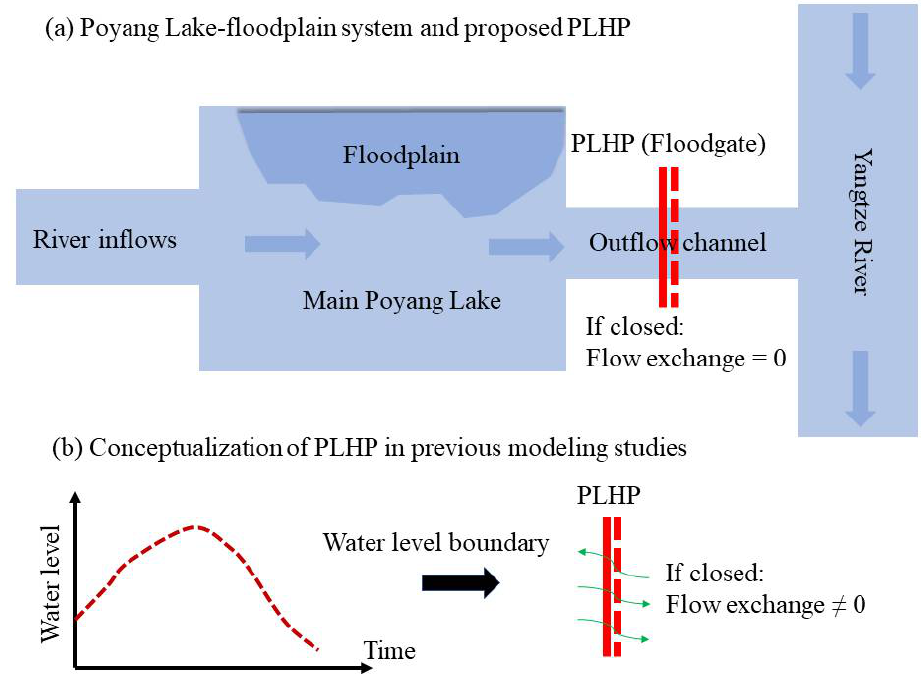
Figure 1. ( a ) Schematic diagram of the Poyang Lake-floodplain system and the proposed Poyang Lake hydraulic project (PLHP). ( b ) Conceptualization of the PLHP in previous modeling studies.